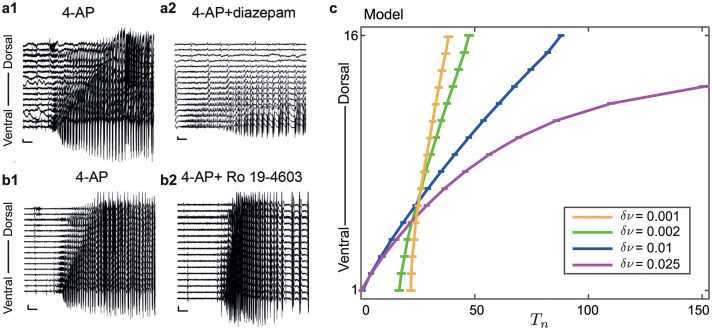
Modulating the excitability gradient changes domino speed.Example traces of seizure-like events induced with application of 4-AP in panels a1 and b1, and with subsequent application of diazepam a2 or Ro19-4603 b2 [13]. Scale bar: 500 μV, 5s. Panel c shows the mean recruitment time of model simulations of the network with different values of excitability gradient δν. Here we fix the coupling weight A = 0.1 and ν0 = 0.14 in line with the red star values in Fig 4. Increasing the gradient δν gives a slower-domino effect, so slow that the realization is terminated before all nodes escape, whereas decreasing the gradient gives as faster-domino effect.